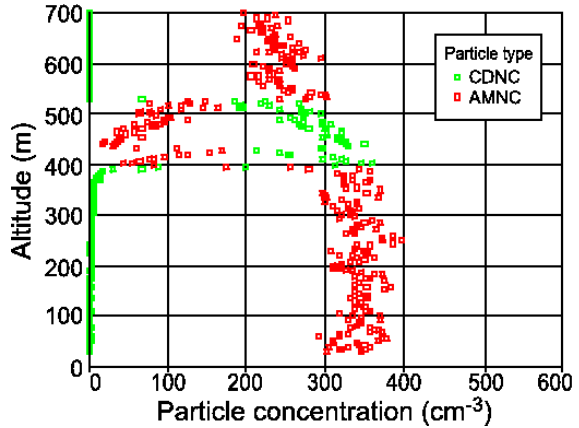
Fig. 1. Vertical profile of the accumulation mode number concen- Figure 1. Vertical profile of the accumulation mode number concentration tration (AMNC) and the cloud drop number concentration (CDNC) (AMNC) and the cloud drop number concentration (CDNC) through the through the stratocumulus deck sampled during CARMA IV on stratocumulus deck sampled during CARMA IV on August 27 th , 2005. 27 August 2005.